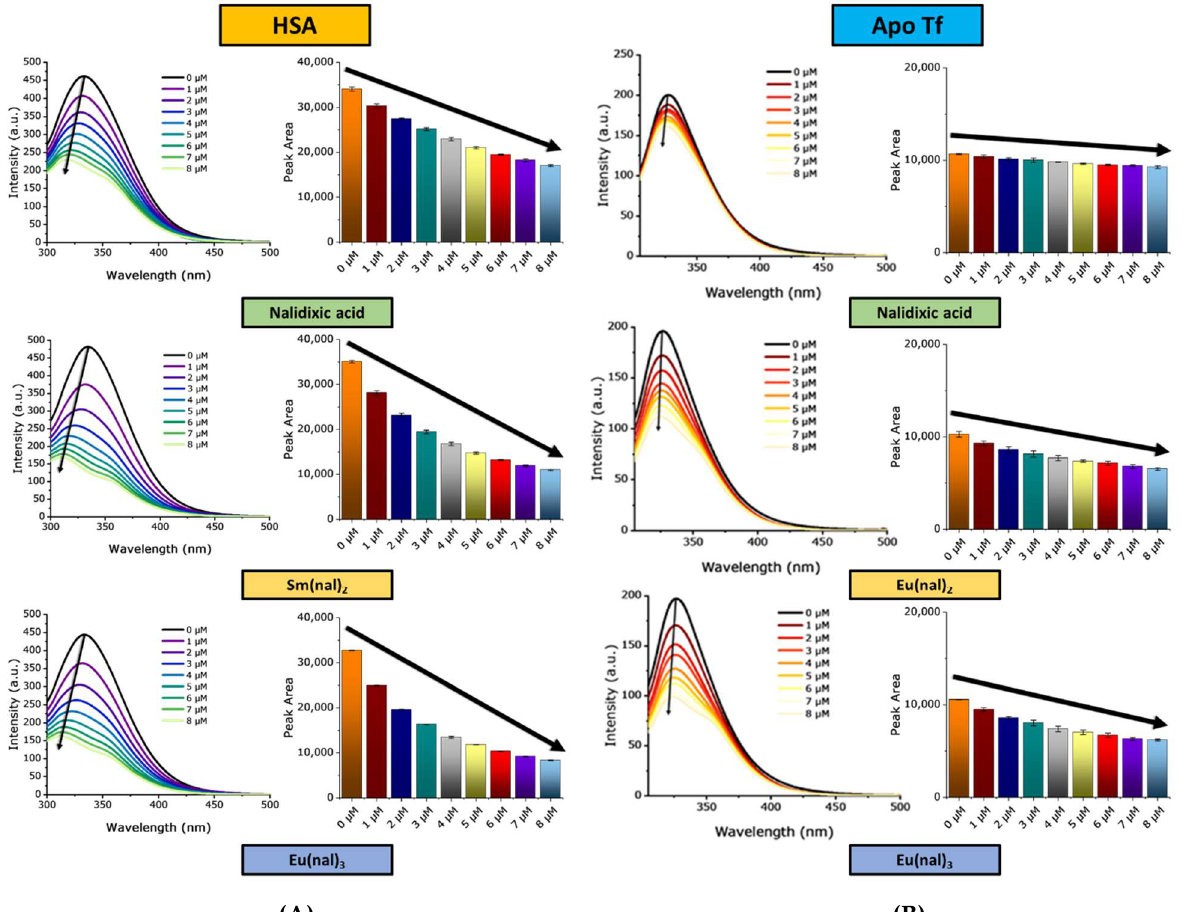
Figure 7. The changes observed in the fluorescence spectra of the free proteins (HSA and apo-Tf) upon addition of increasing amounts of complexes: ( A ) [HSA] = 2.5 μM, [complex] = 0, 1, 2, 3, 4, 5, 6, 7, 8 μM; ( B ) [apo-Tf] = 1 μM, [HSA] = 2.5 μM, [complex] = 0, 1, 2, 3, 4, 5, 6, 7, 8 μM. The black arrows indicate the decrease of the peak with increasing concentrations of complex.